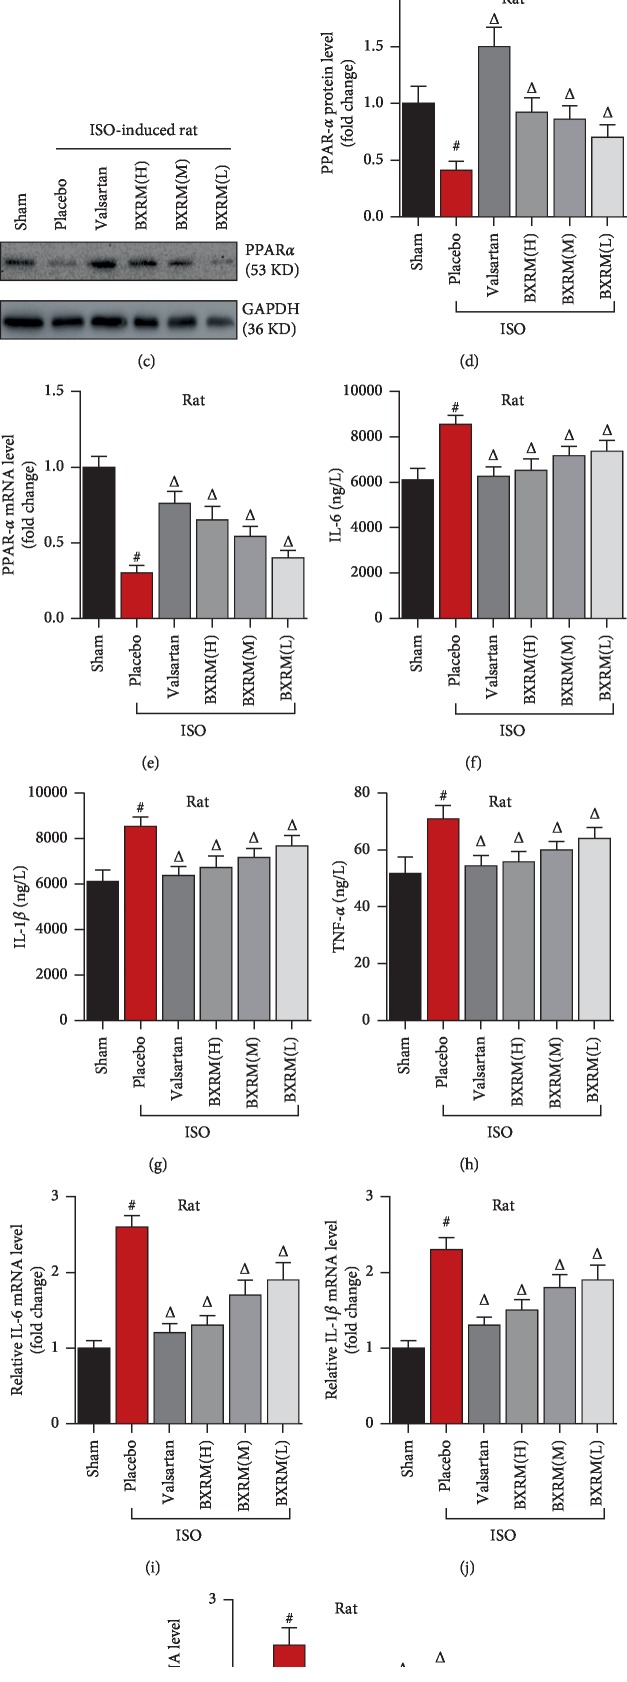
Granule of BU-XIN RUAN-MAI improves the oxidation and inflammation in myocardial ischemia of rats caused by isoprenaline. (a) Granule of BU-XIN RUAN-MAI attenuated myocardial cell injury in rats demonstrated by H&E staining. (b) The effects of Granule of BU-XIN RUAN-MAI on the content of MDA (μmol/L), SOD (U/mL), Na+/K + -ATPase (μmol/g protein), and cAMP (pmol/L); data shown are mean ± SD; #P < 0.05 versus the normal group (sham) and ΔP < 0.05 versus the model group (ISO). (c) Granule of BU-XIN RUAN-MAI significantly enhanced the PPARα protein expression analyzed by Western blot, and (d) the corresponding semi-quantitative analysis was based on optical density with ImageJ software; data shown are mean ± SD; #P < 0.001 versus the sham group and ΔP < 0.05 versus the model group. (e) Granule of BU-XIN RUAN-MAI significantly increased the PPARα mRNA expression determined by real-time PCR; data shown are mean ± SD; #P < 0.001 versus the sham group and ΔP < 0.05 versus the model group. (f, g, h) Granule of BU-XIN RUAN-MAI elevated the content of IL-6, IL-1β, and TNF-α detected by ELISA; data shown are mean ± SD; #P < 0.001 versus the sham group and ΔP < 0.05 versus the model group. (i, j, k) Granule of BU-XIN RUAN-MAI enhanced the IL-6, IL-1β, and TNF-α mRNA expressions analyzed by real-time PCR; data shown are mean ± SD; #P < 0.001 versus the sham group and ΔP < 0.05 versus the model group. The data are representative of three independent experiments.